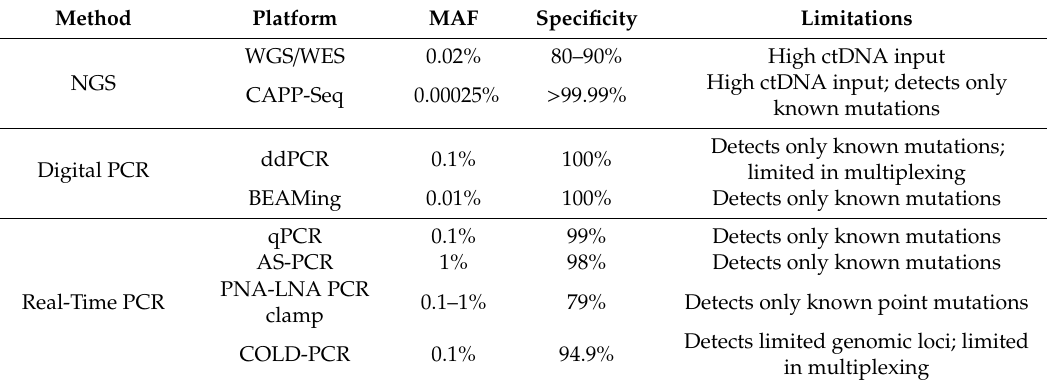
Table 3. PCR- and NGS-based method for mutation analysis of cfDNA. MAF: Minimum Allele